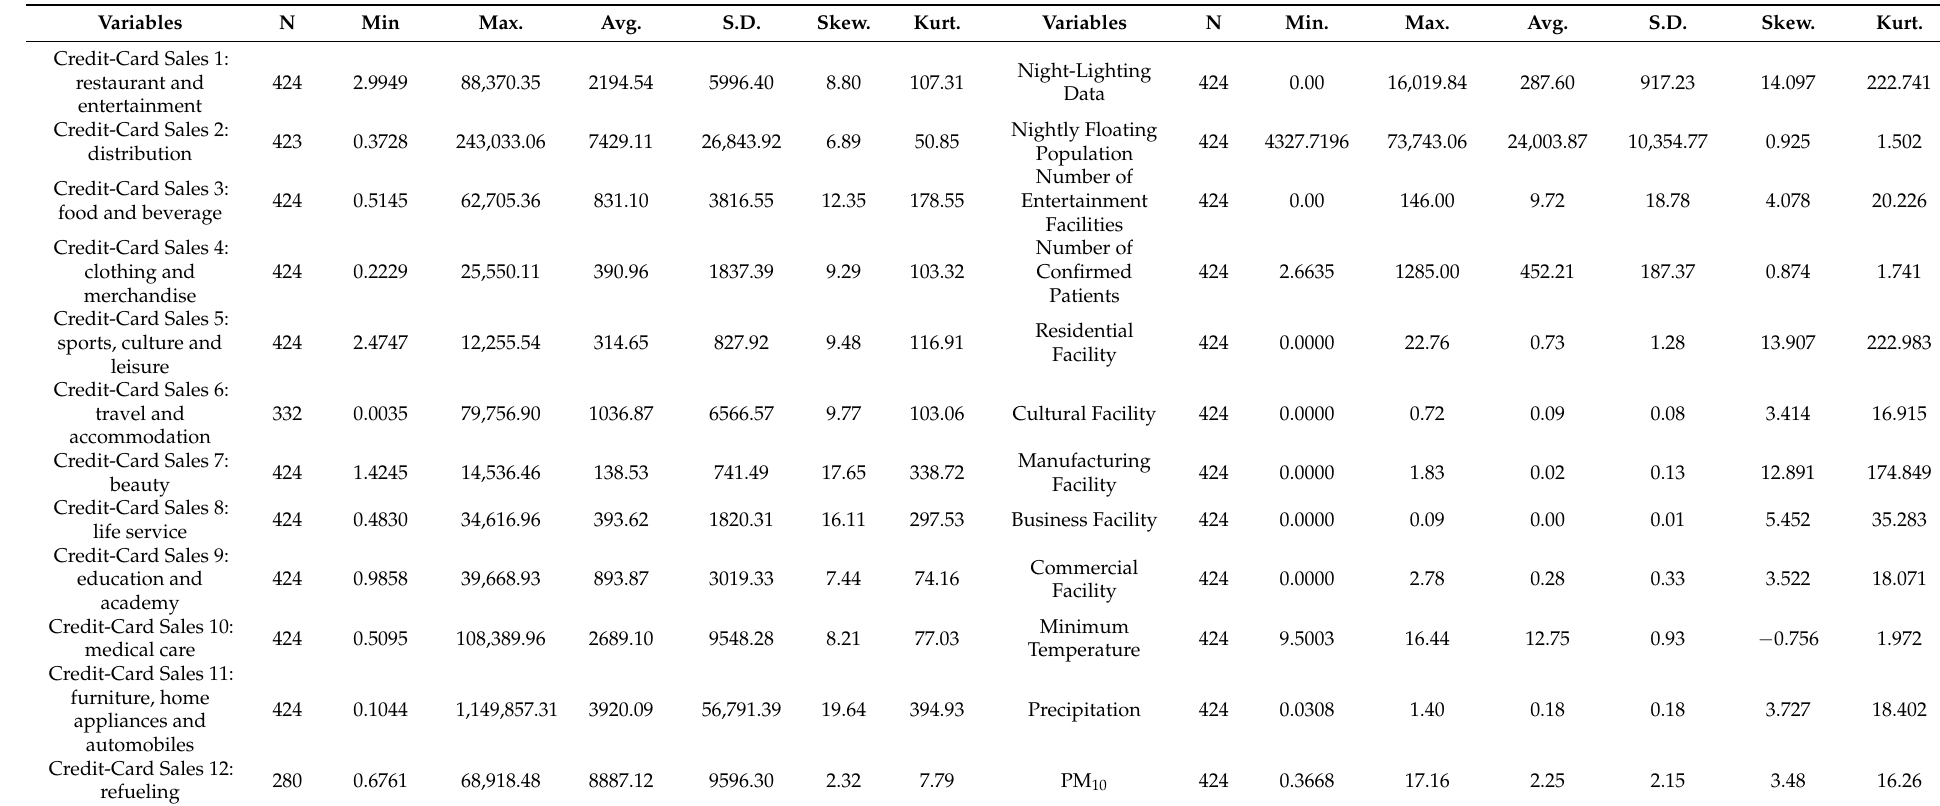
Table 3. Frequency analysis